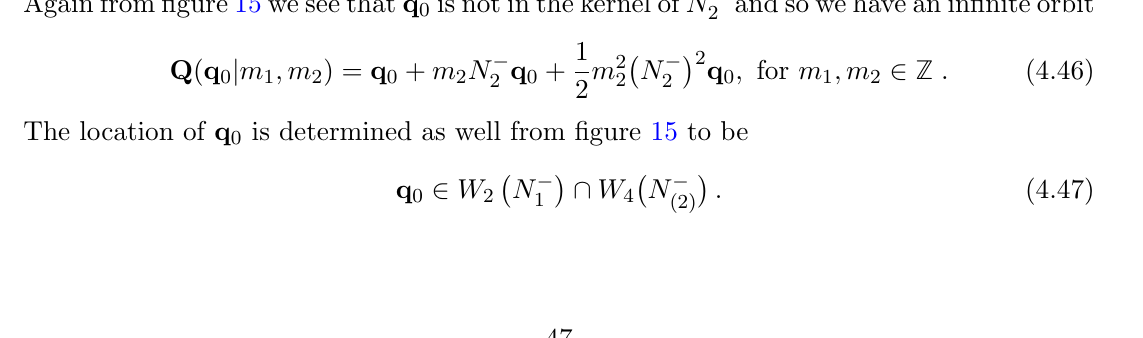
), the middle picture a 1 . The colourings are 2 are denoted 0